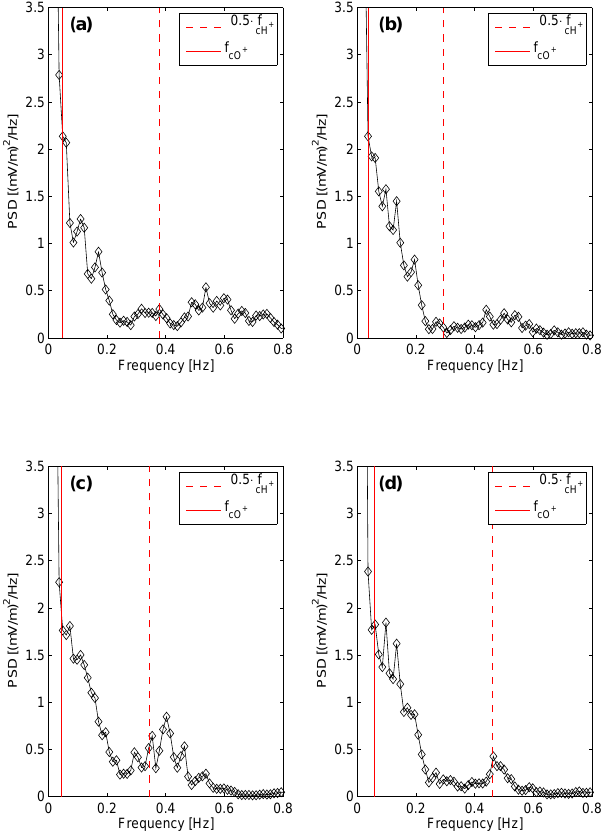
Fig. 3. The power spectral density for the electric field observed during the event (see Fig. 1). The vertical solid line and dashed line indicate the oxygen gyrofrequency and half of the proton gyrofre- quency respectively. The time span in panel: (a) is 17:50–17:55, (b) is 17:55–18:00, (c) is 18:00–18:05 and (d) is